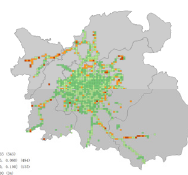
Figure 13. ( a ) Grid carbon emissions (G-c) of each grid area at 1:00 a.m.–3:00 a.m. ( b ) Grid carbon emissions (G-c) of each grid area at 7:00 a.m.–9:00 a.m. ( c ) Grid carbon emissions (G-c) of each grid area at 5:00 p.m.–7:00 p.m. ( d ) Grid carbon emissions (G-c) of each grid area at 8:00 p.m.–10:00 p.m.